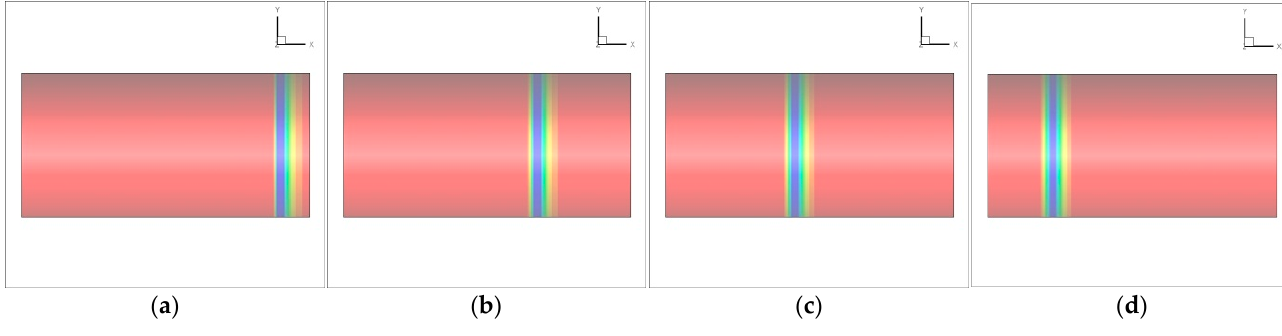
Figure 4. Pressure distribution when the pulse propagates in the pipe (blue represents the amplitude): ( a ) 0.02 s, ( b ) 0.04 s, ( c ) 0.06 s, ( d ) 0.08 s. The pressure is stable before 0.01 s, and there is a negative pressure zone in the pipe with the input of pressure pulse. The negative pressure zone shows regular pressure layers between which the interfaces are plane. The moving speed of the zone is acoustic velocity. Because the boundary layer of the pipe wall is not considered, the acoustic wave propagates in the form of a standard plane wave. Additionally, in the propagation process, the negative pressure zone becomes wider, especially the front of the zone. Pressure at the monitoring points without pulse inlet is subtracted from pressure at the corresponding monitoring points with pulse inlet. The results are acoustic pressure amplitude variation, as shown in Figure 5.